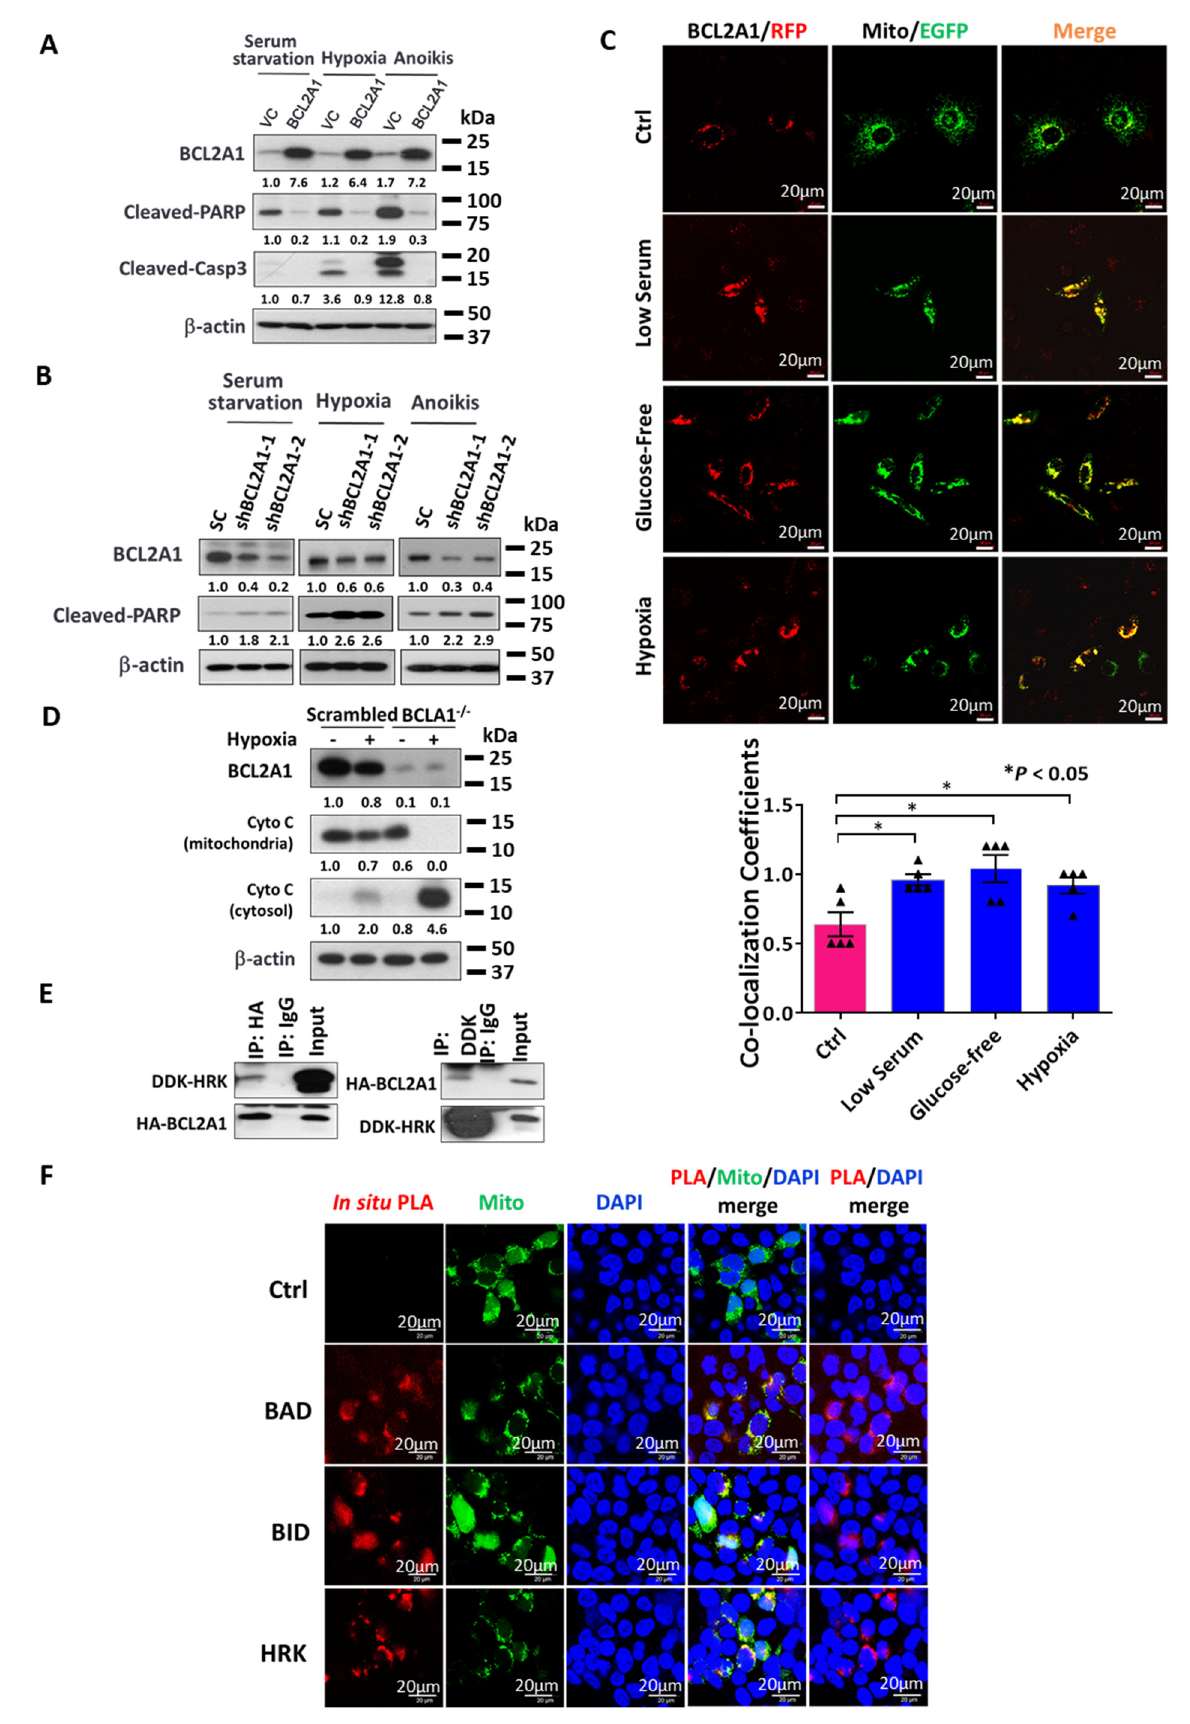
Figure 6. BCL2A1 enhances the cell survival of ovarian cancer cells through suppression of the intrinsic apoptotic